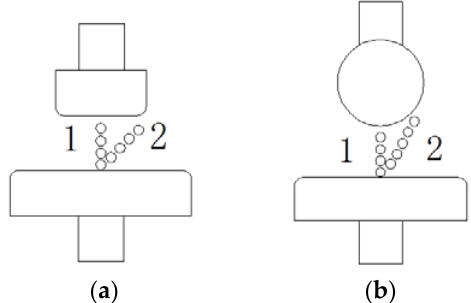
Figure 6. The bubbles of the cylinder-plan and sphere-plan electrodes, where 1 is the initial bubbles; 2 shows the bubbles affected by the corona; ( a ) the bubbles of the cylinder-plan electrodes; and, ( b ) the bubbles of the sphere-plan electrodes.